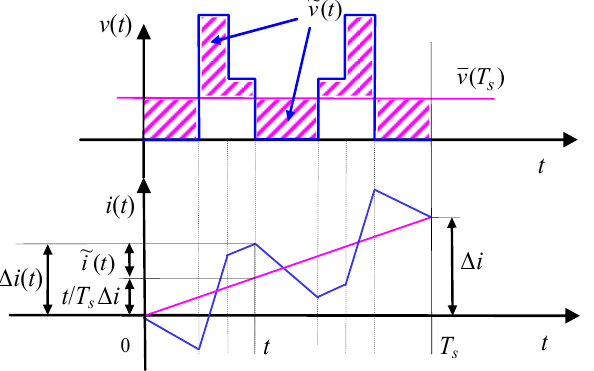
Figure 2. Details of a generic output voltage and current ripple in the switching